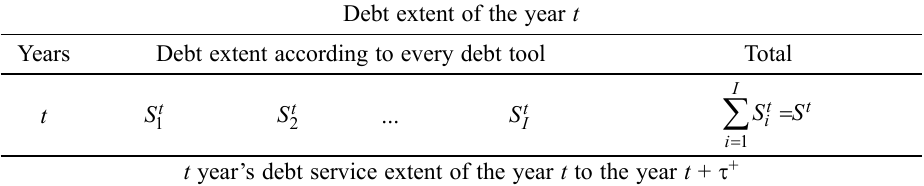
Scheme 1. Digest on the formation of servicing components and their present values pertaining to the debt obtained in the year t , or the formation logics of the present value P ( S t ) of debt